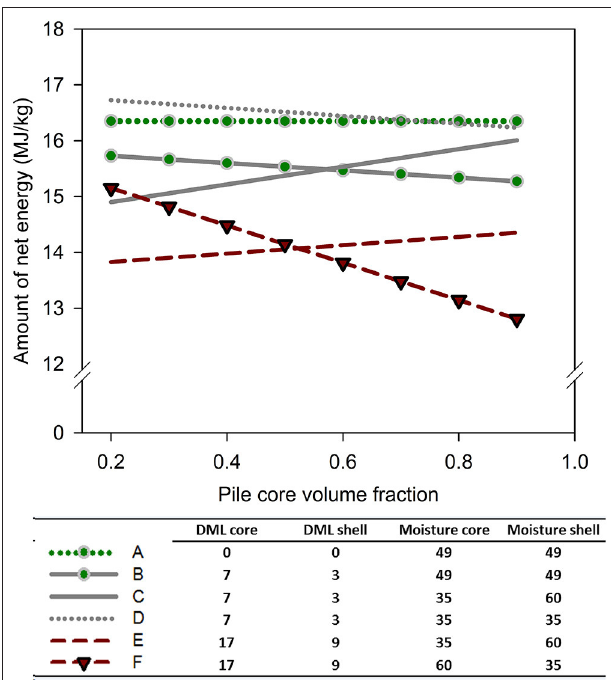
FIGURE 6 | Calculated net energy from 1kg (oven dry) harvested willow chips for different pile core volume fractions for selected dry matter loss (DML) and moisture content. Case A represents the situation when the harvested biomass is combusted immediately after harvest with no DML. Cases B–F represent different hypothetical situations depicting different DML and moisture values for stored chips. The higher heating value (HHV) for this calculation is 18.7